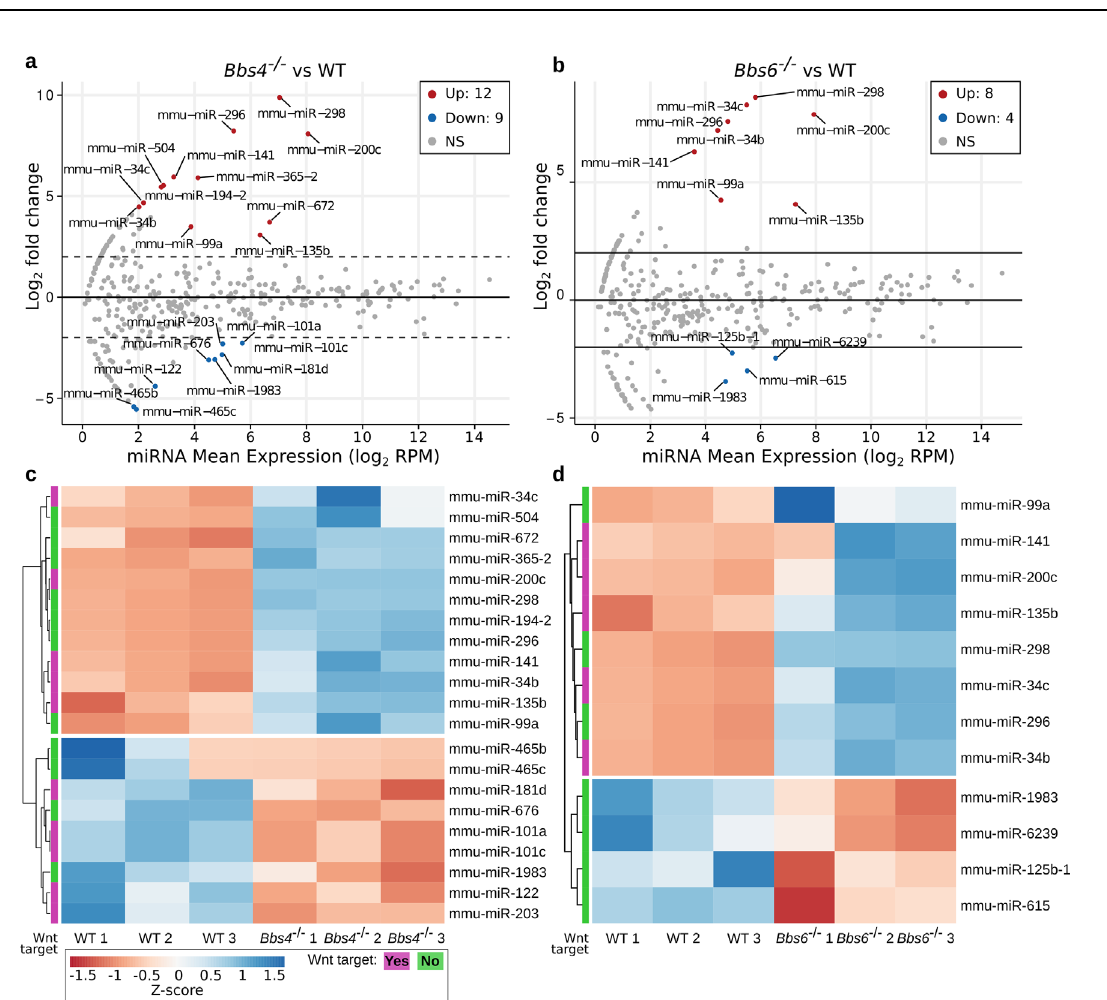
Fig. 4 smEVs released from cilia mutant cells contain differentially loaded miRNAs involved in Wnt signalling. a , b Volcano blots of miRNAs isolated from three independent smEV prepartions from Bbs4 − / − ( a ) and Bbs6 − / − ( b ) cells compared to control. Upregulated miRNAs are depicted by red dots, downregulated by blue dots. c , d Heatmaps of all differentially loaded miRNAs with a log2 fold change ≥ 2 or ≤ − 2 and adjusted P value <0.1 compared to control. miRNAs with target genes related to the Wnt signalling pathway are marked in purple. Source data are provided as a Supplementary data fi le.